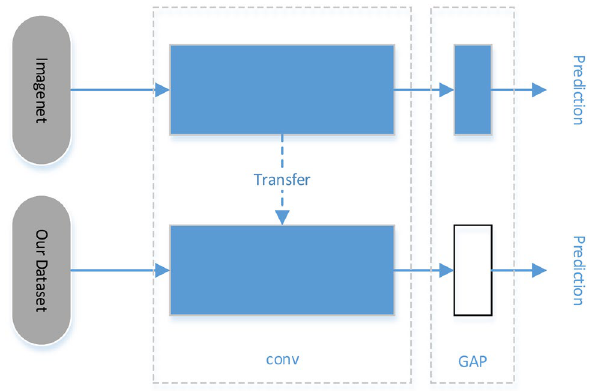
Fig. 8 Schematic diagram of the transfer learning process